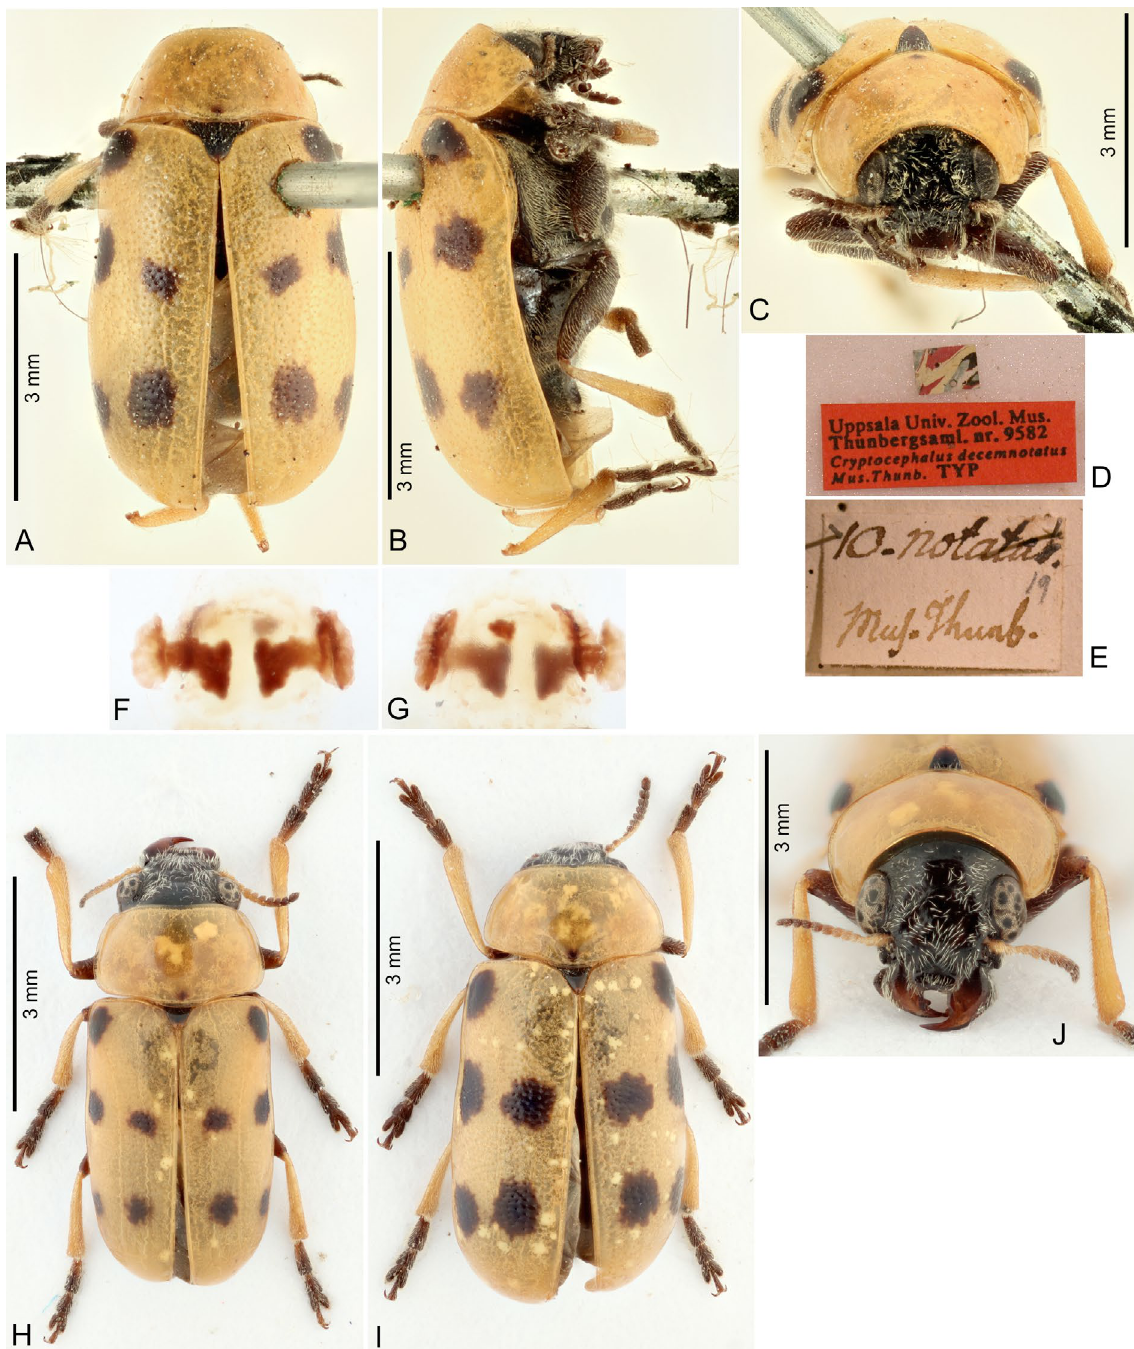
Fig. 4. Melitonoma decemnotata (Thunberg, 1787) comb. nov. A–E . Syntype, ♀, 5.8 mm, UUZM. A . Dorsal view. B . Lateral view. C . Frontal view. D . Labels. E . Box label. F–G . Kotpresse. F . Ventral view. G . Dorsal view. H . ♂, 6.1 mm, RSA, Worcester, BMNH. I . ♀, 5.7 mm, RSA, Worcester, BMNH. J . Male head, frontal